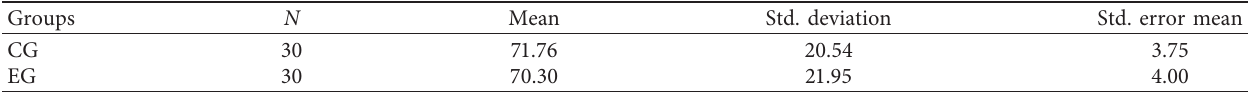
Table 5: Means and standard deviations of both groups on the reading motivation pretest.